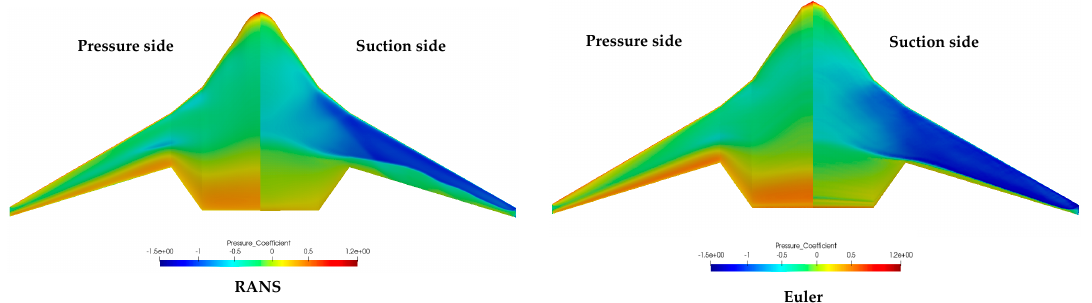
Aerospace 2020 , 7 , x